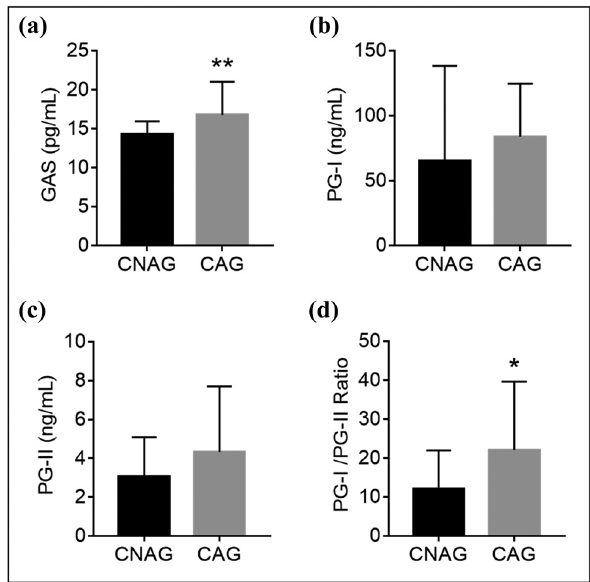
Figure 1: Common serum biomarkers level in CAG patients. ( a ) Serum GAS level in the CNAG group ( n = 30 ) and CAG group ( n = 30 ) . ( b ) Serum PGI level in the CNAG group ( n = 30 ) and CAG group ( n = 30 ) . ( c ) Serum PGII level in the CNAG group ( n = 30 ) and CAG group ( n = 30 ) . ( d ) Serum PGI/PGII ratio in the CNAG group ( n = 30 ) and CAG group ( n = 30 ) . * p < 0.05 and ** p < 0.01.